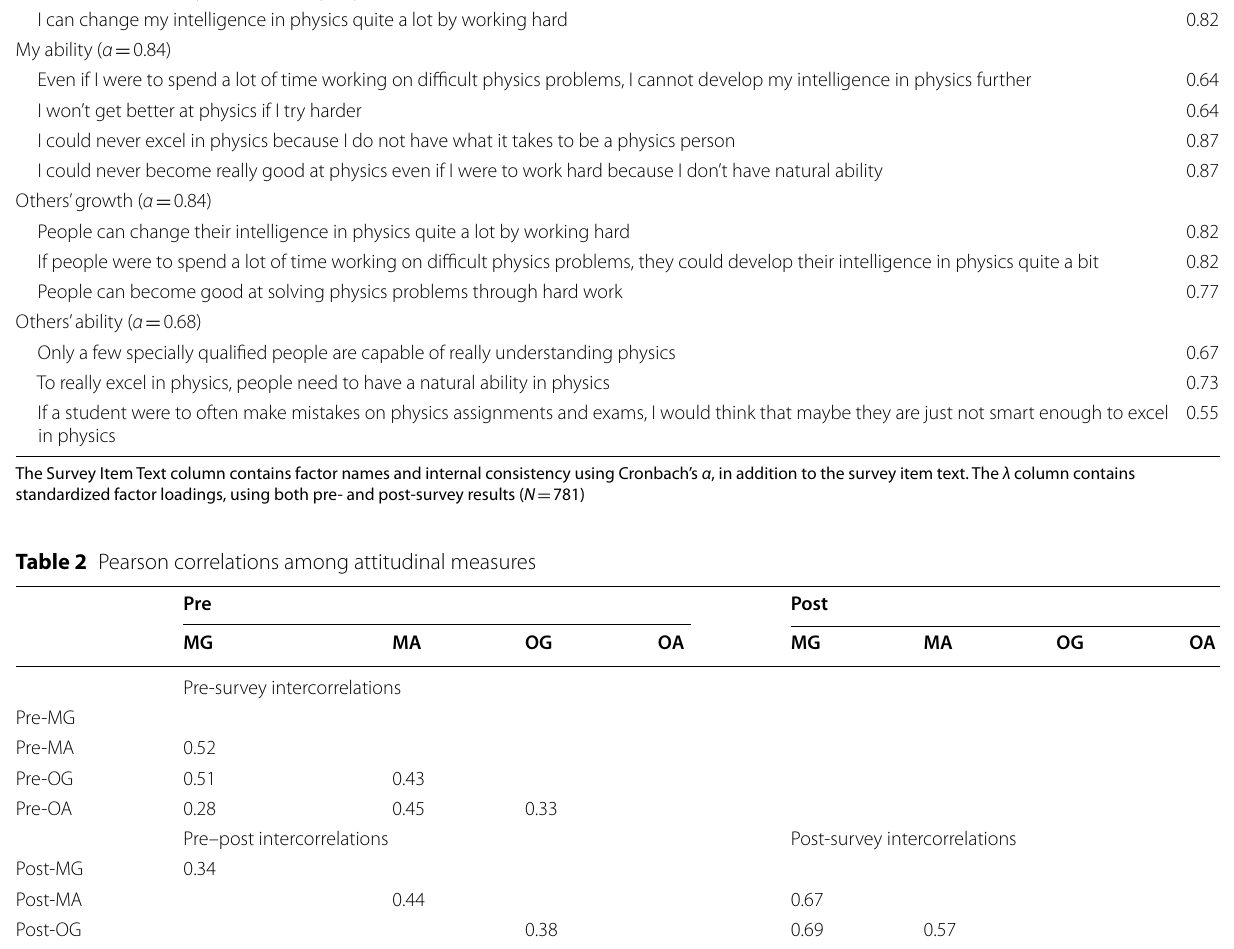
Clockwise from top left: pre, post, and pre- versus post-Pearson correlations between constructs. The following terms are abbreviated: My Growth (MG), My Ability (MA), Others’ Growth (OG), and Others’ Ability (OA). All correlations are statistically significant at p < 0.001